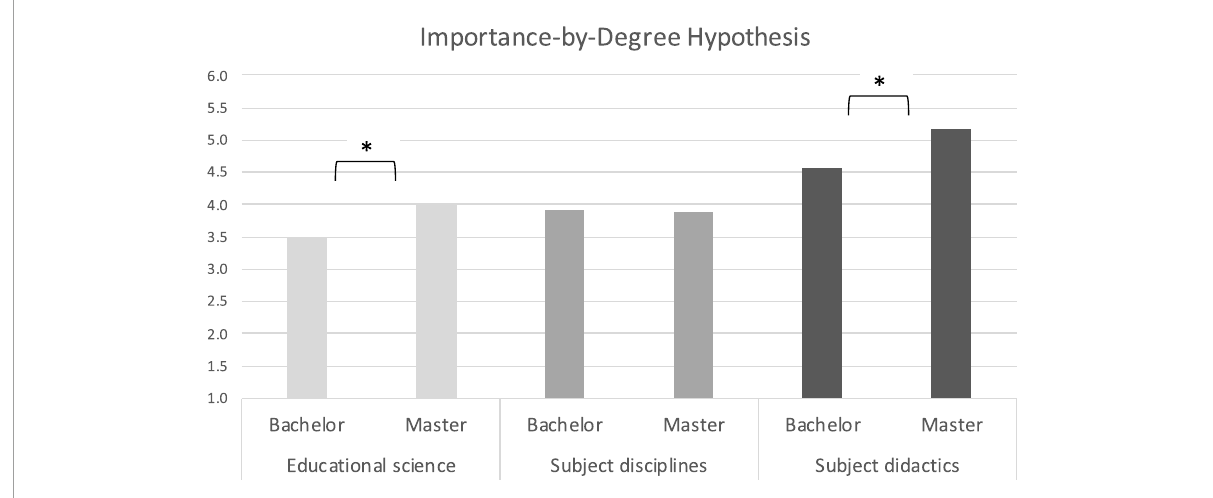
FIGURE1 Interaction effects: Importance of the disciplines for professional success as a function of degree program (Sub-Study 1). The figure displays beliefs about the importance of the three disciplines for professional success among students at the bachelor’s vs. master’s level. ∗ p < 0.05 in the simple effects